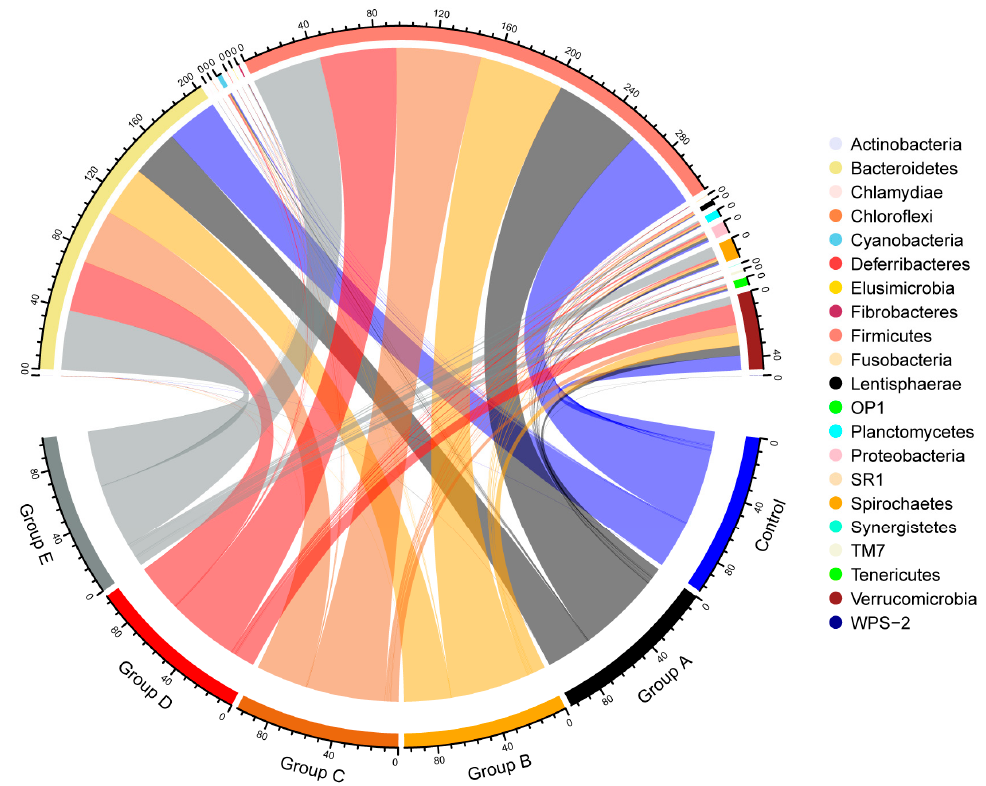
Figure 2. Bacterial composition of different groups at the phylum level. The circlize plot shows the average relative abundance of each bacterial taxon (phylum level). There are 21 phyla for each group exhibited here, and Firmicutes and Bacteroidetes are the dominant phyla for each group.